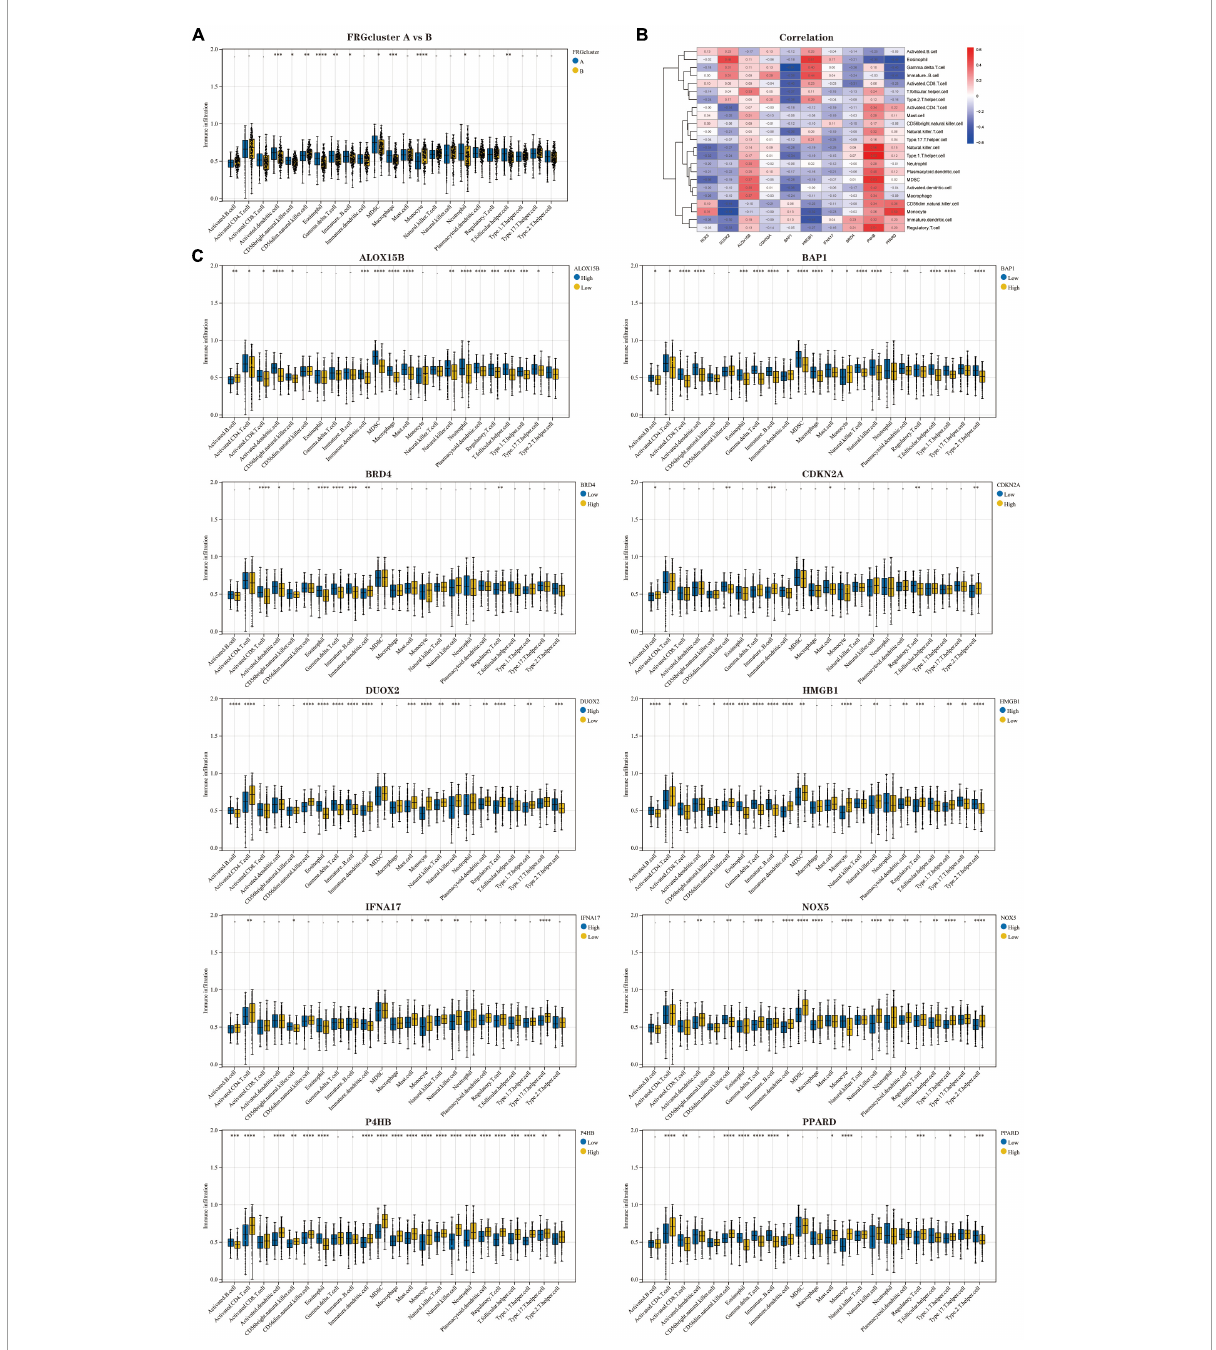
FIGURE5 Analysis of immune cell infiltration in the two clusters of patients with AD. (A) Comparison of the percentage of immune cell infiltration between FRGcluster A and B. Blue represents FRGcluster A; yellow represents FRGcluster B. (B) Heatmap of the correlation between Hub genes and 28 immune cells with a colour gradient change from red (positive correlation) to blue (negative correlation). (C) Comparison of the differences in immune cell abundance between the high and low expression groups for each Hub gene. ∗ P < 0.05; ∗∗ P < 0.01; ∗∗∗∗ P < 0.001. FRGcluster, Ferroptosis-related gene cluster.